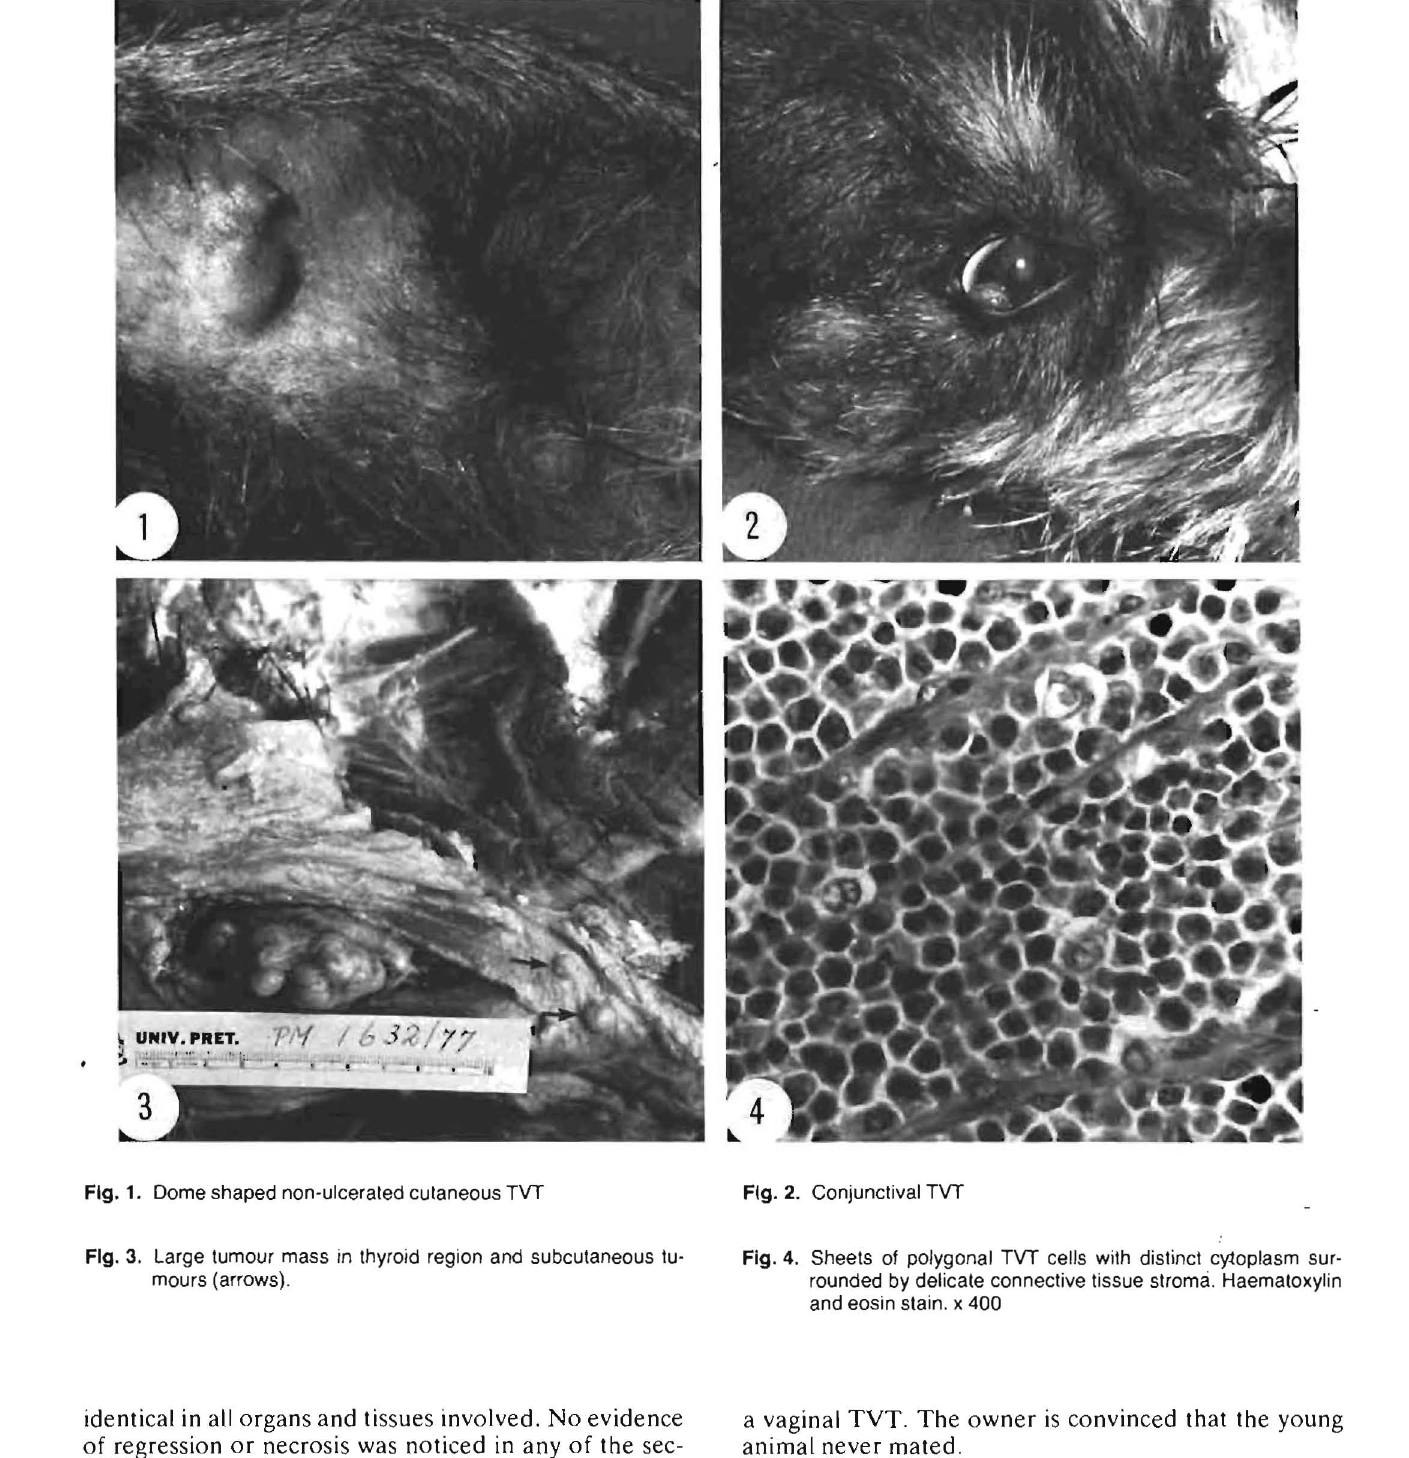
Fig. 2. Conjunctival TVT Fig. 4. Sheets of polygonal TVT cells with distinct cytoplasm sur rounded by delicate connective tissue stroma. Haematoxylin and eosin stain. x